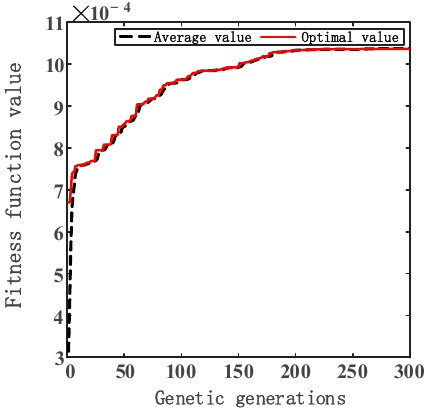
Figure 9. The change curve of fitness function value.